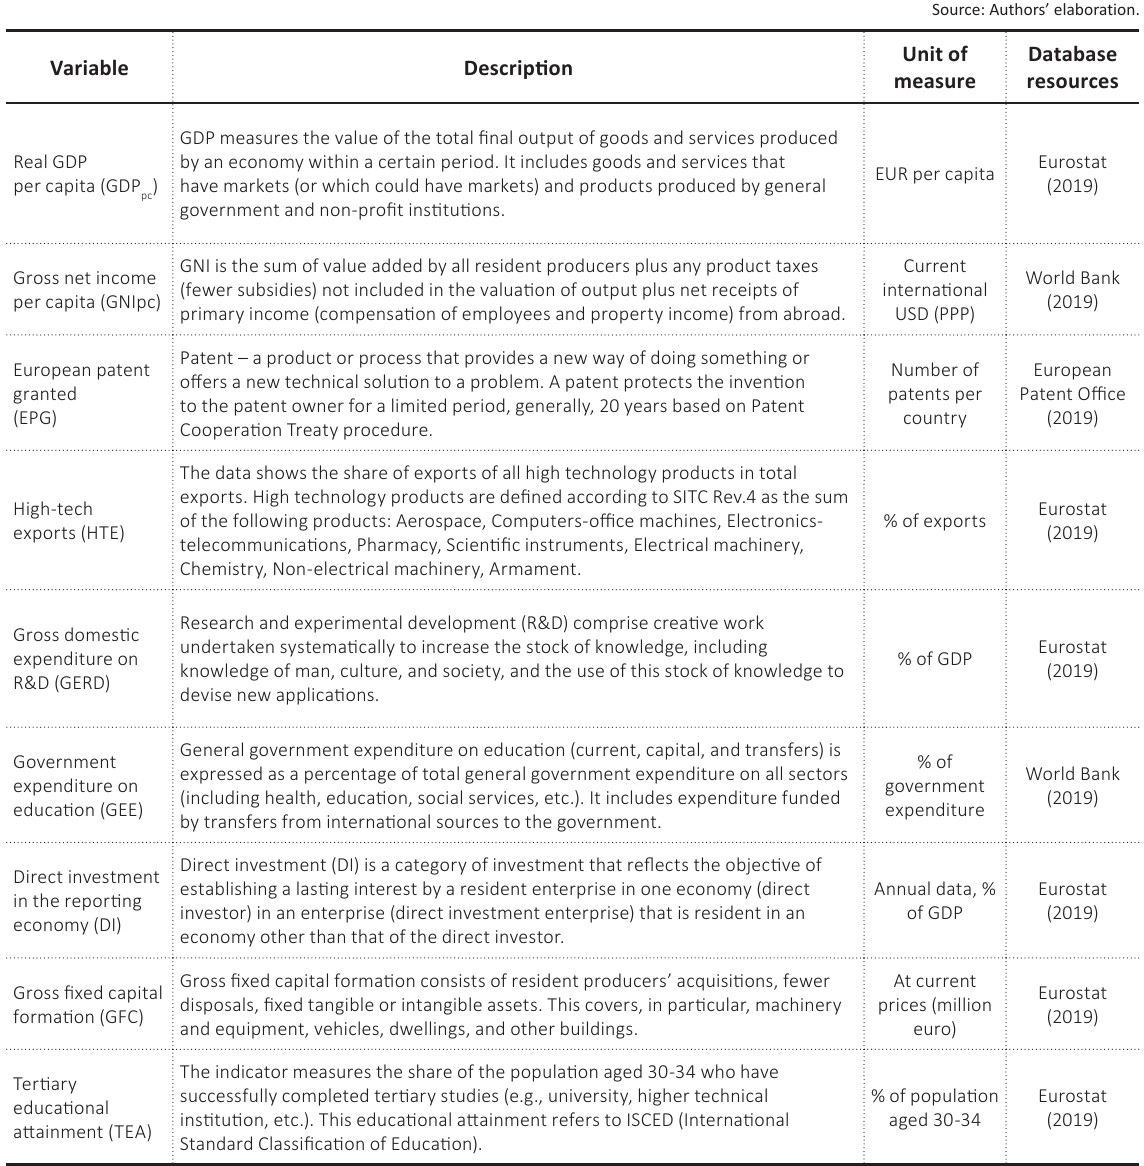
Table 2. Definition of selected variables entering into